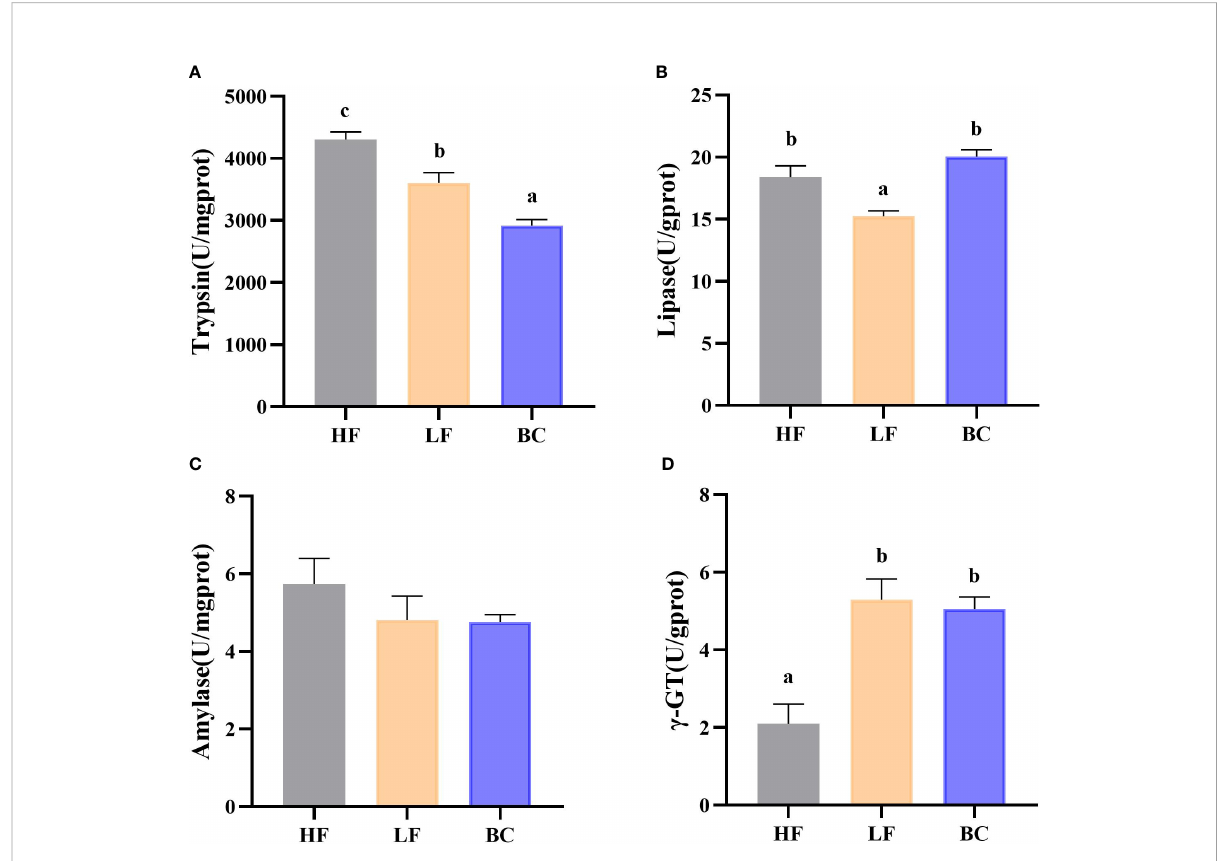
FIGURE 2 (A – D) Intestinal digestive enzymes and brush border enzyme activity. (A) Intestinal trypsin activities; (B) Intestinal lipase activities; (C) Intestinal amylase activities; (D) Intestinal g -GT